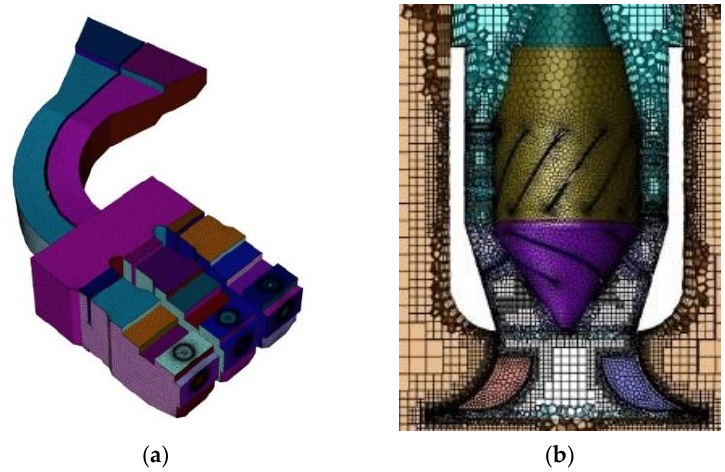
Figure 4. Mesh model of inlet channel. ( a ) Overall mesh. ( b ) Refined mesh.